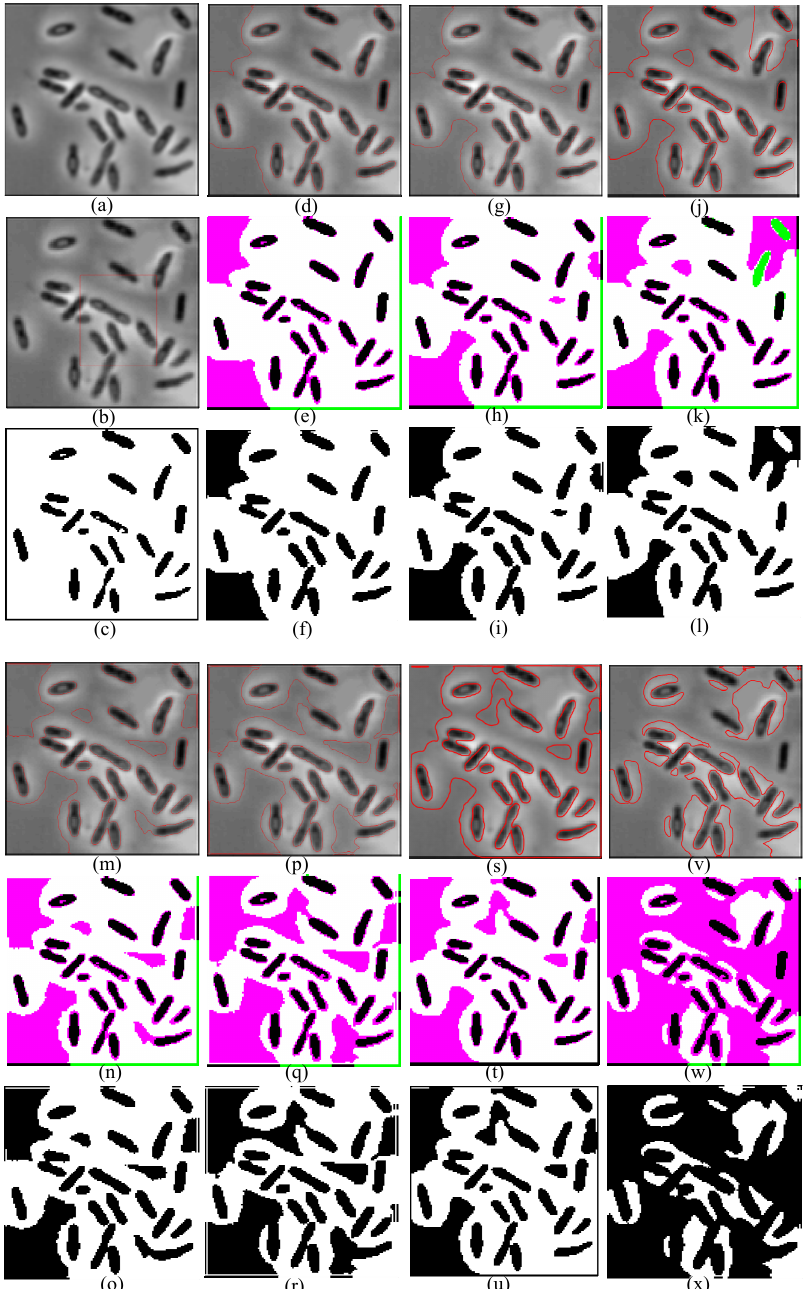
( u ) the ground truth of CV model; ( v ) the segmentation result of ALFB model; ( w ) the comparison map of ALFB model; and ( x ) the ground truth of ALFB model.